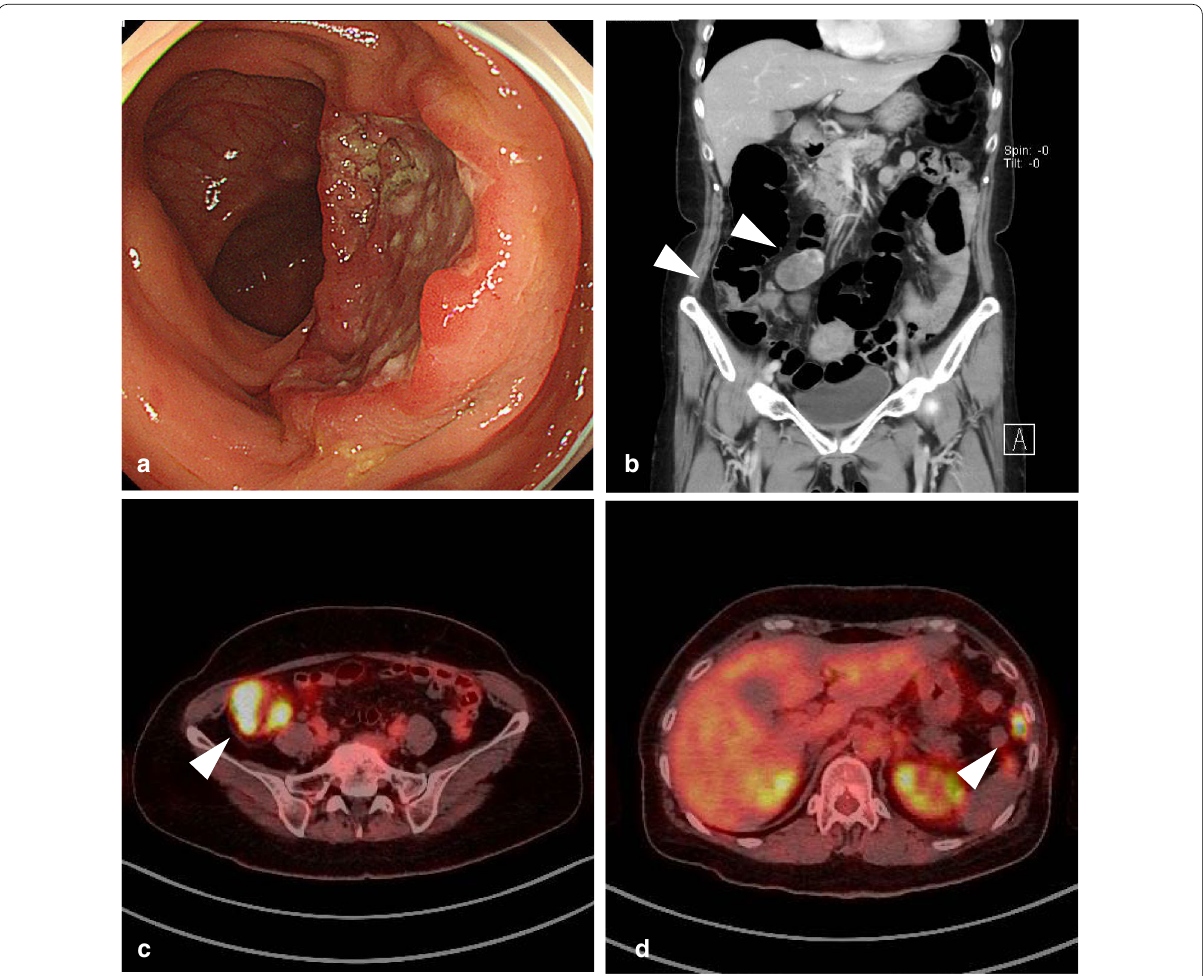
Fig. 1 a Colonoscopy showed a semicircular type 3 tumor in the ascending colon. b CT showed a mass in the ascending colon with regional lymph node enlargement (arrowheads). c , d FDG-PET showed abnormal FDG uptake in the lesion in the ascending colon and peritoneal thickening of the left upper